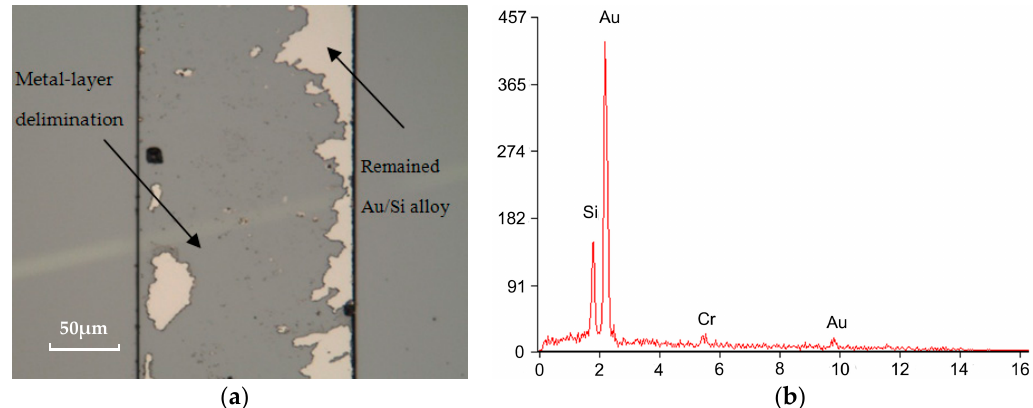
Figure 6 . Optical photograph and component analysis of separated surface for Cr/Au layer. ( a ) Metal layer peeling off of the substrates; ( b ) component analysis of Au/Si alloy.